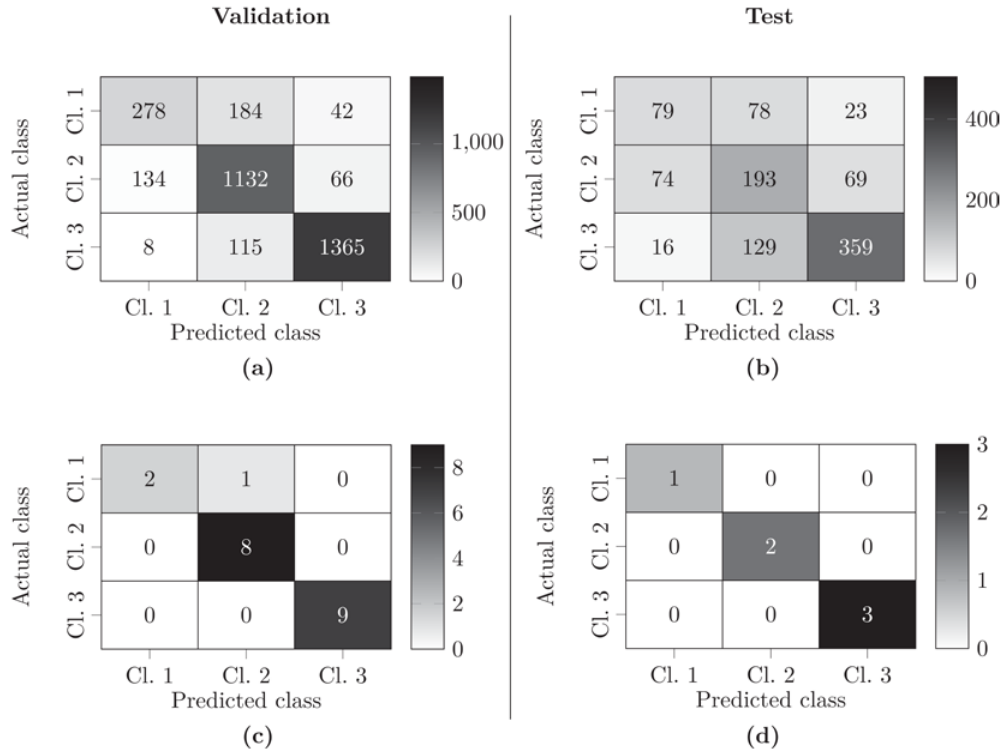
Figure 3. Confusion matrices for the classification of kidneys into the three classes: nonfunctional (class 1), limited functional (class 2), functional (class 3). Results of the KidneyResNet model No. 10 of Section 3.3 for validation/test after the classification of individual ROIs ( a , b ) and by the majority decision of all ROIs of a kidney ( c , d ).